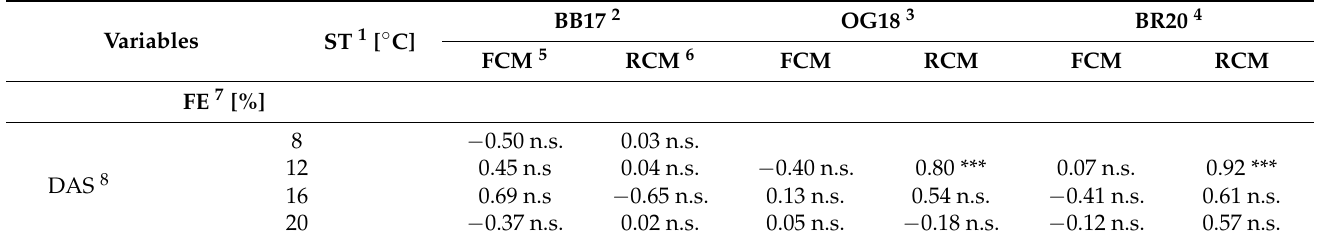
Table 3. Pearson’s correlation among field emergence and soil temperature at 8, 12, 16 and 20 days after sowing) in flat cultivation method (FCM) and ridge cultivation method (RCM) over Environments BB17, OG18 and BR20. *** indicates significance, and n.s.—not significant at p < 0.05. ST 1 [ ◦